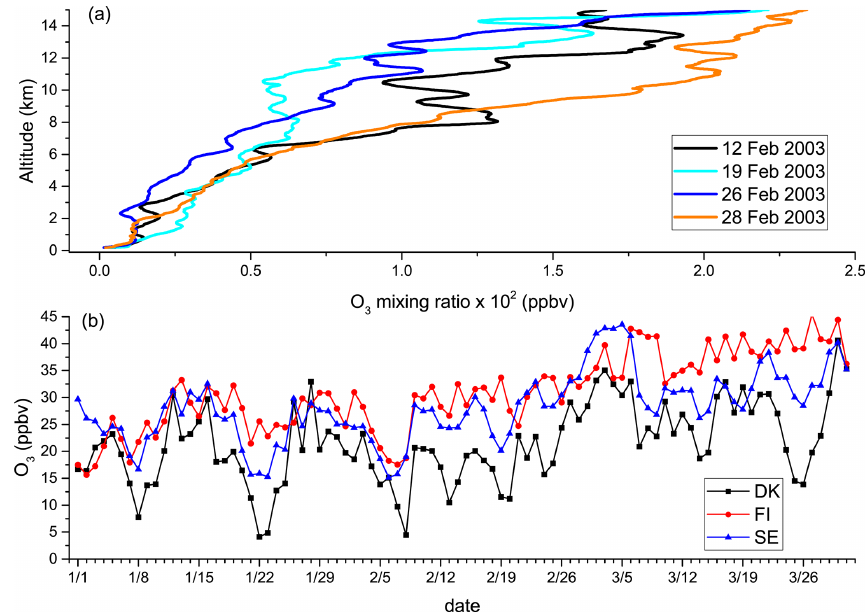
Figure 8. (a) Vertical profiles of ozone mixing ratios (ppbv) obtained by ozone soundings at the Sodankylä Arctic station during 4 different days in February 2003: 12, 19, 16 and 28 February 2003; (b) Daily mean O 3 concentrations recorded at ground-based air quality stations located in Denmark (DK), Finland (FI) and Sweden (SE) during January–March 2003. Table 3. Statistical parameters indicating the model performance in reproducing observed 7 Be weekly (daily in the case of Helsinki) means at the six sampling sites in northern Europe. The asterisk aside the value of the correlation coefficient and of the Z indicates that the value is statistically significant at the 0.05 significance